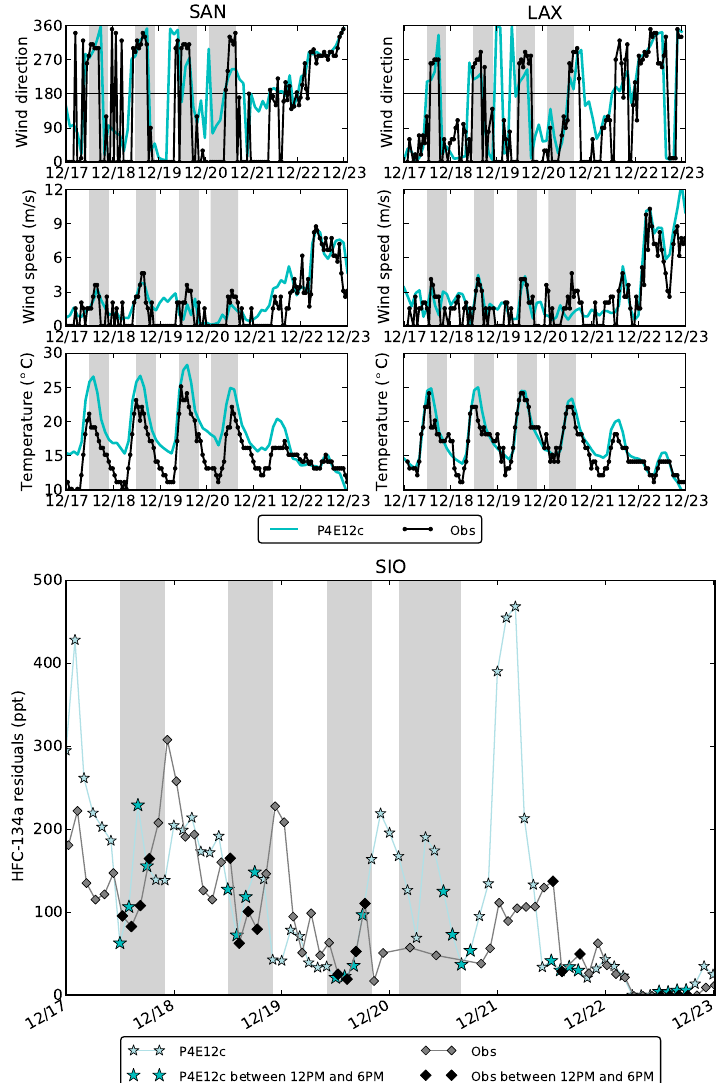
Fig. 10. Wind direction, wind speed, temperature and HFC-134a observed and simulated (P4E12c) residuals between 17 and 25 December 2009. The Santa Ana events are shown with grey bars.